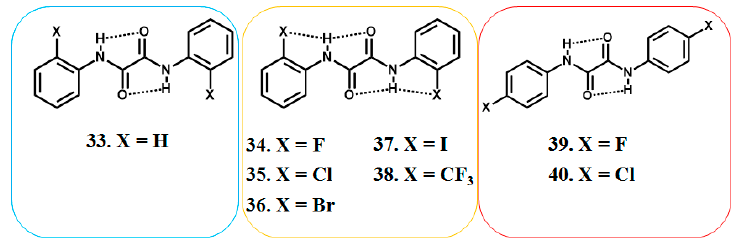
Figure 33. Chemical structures of N,N -diphenyloxamide ( 33 ) and its derivatives 34 – 40 . The dotted line3 indicate the HBs.